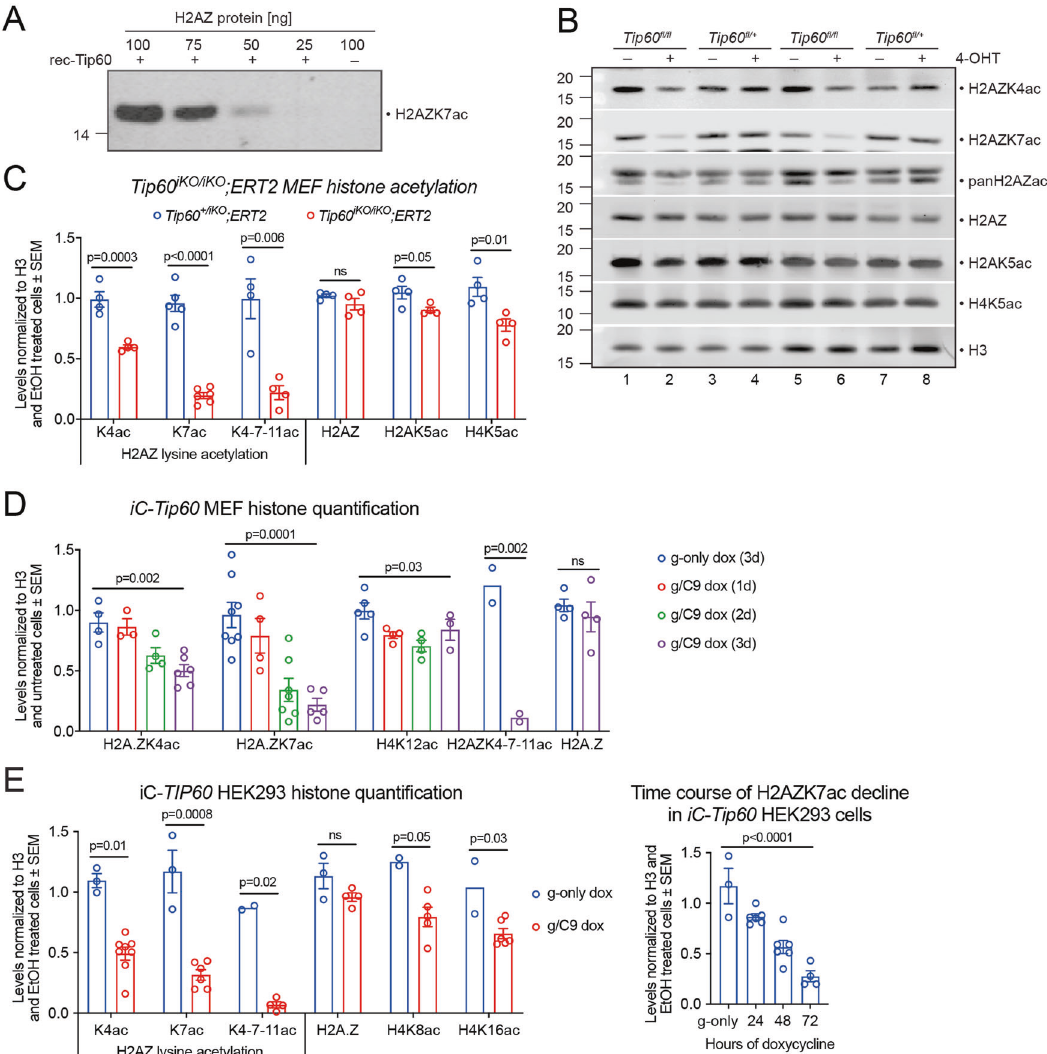
Fig. 3 TIP60 is essential for histone H2AZK7 acetylation in human and mouse cells. A Cell-free acetylation assay analyzed by Western blot shows full-length recombinant H2AZ histone, with (lane 1 – 4) and without (lane 5) recombinant TIP60 (rec-Tip60). B Representative Western blots of acid extracted proteins from Tip60 fl / fl ;ERT2 MEFs treated with vehicle (EtOH, − ) or 4-OHT ( + ) for 3 days and probed for histone and histone acetylation levels as indicated. Total H3 was used as a loading control. C Fold change of histone lysine acetylation levels normalized to total H3 protein after 3 days of EtOH or 4-OHT treatment. Shown are Tip60 + /iKO ;ERT2 control MEFs and Tip60 iKO/iKO ;ERT2 MEFs. D Fold change of histone lysine acetylation levels normalized to H3 between iC-Tip60 and control MEFs. E Fold change of histone lysine acetylation levels normalized to H3 between iC-TIP60 and control HEK293 cells after 3 days of dox treatment and time-course of H2AZK7ac decline. Data from sgRNA#1 and sgRNA#2 were combined. Means ± SEM of 2 to 8 independent experiments are shown ( C – E ). Circles represent individual data points of replicates ( C – E ). Data were log-transformed and analyzed by unpaired two-tailed t test ( C , E left panel) or one-way ANOVA with Benjamini and Hochberg correction ( D , E right panel). Experiments assessing acetylation of histones H2A, H3, and H4 at speci fi c lysine residues are displayed in Figure S6 and full-size Western blots are displayed in the supplemental Table S3). Among the top 10 enriched biological processes, 8 were downregulated, including gene expression, protein translation, and associated processes (Fig. 5D; Table S3), consistent with cell cycle arrest and reduced requirement for metabolism and protein synthesis after the loss of TIP60. Transcription and gene expression processes overall were downregulated in the absence of TIP60 (Fig. 5D; Table S3). Downregulated pathways included p53-signaling, cell cycle regulation, apoptosis, and necroptosis (Table S4), congruent with the observation that TIP60 knockout MEFs neither proliferate, nor undergo apoptosis or other forms of cell death, but rather enter cell cycle arrest.